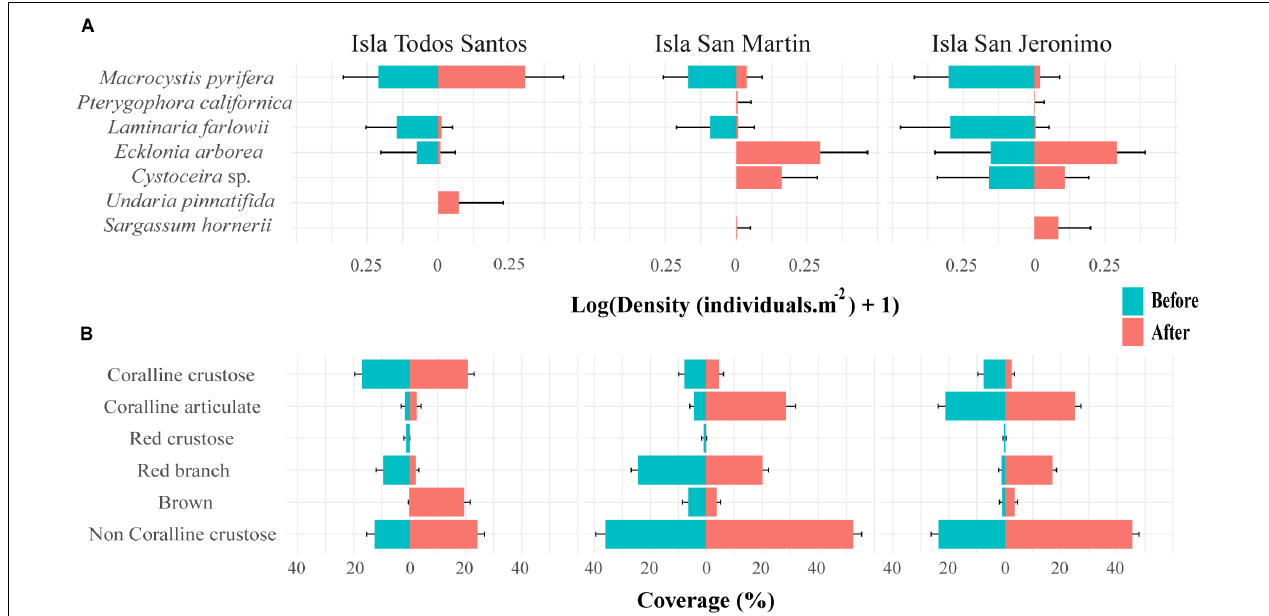
FIGURE 8 | (A) Density of Macrocystis pyrifera , subcanopy algae, and introduced algae species (mean number of individuals.m − 2 , n = two sites with three video transects, ± 95% confidence intervals). (B) Percent cover (mean, n = two sites with three video transects, ± 95% confidence intervals) of understory algae from before to after the 2014–2016 MHWs at Isla Todos Santos, Isla San Martín, and Isla San Jeronimo, in Baja California, Mexico.